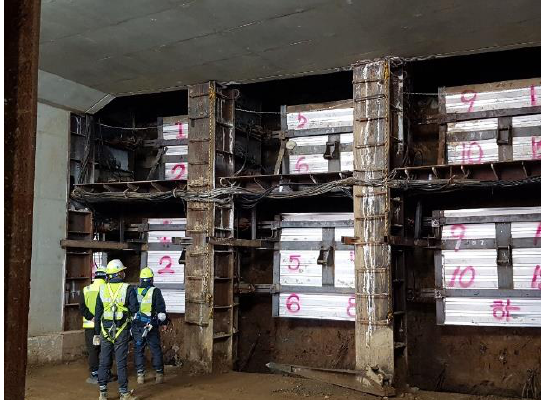
Figure 4. Two levels under construction tunnel.